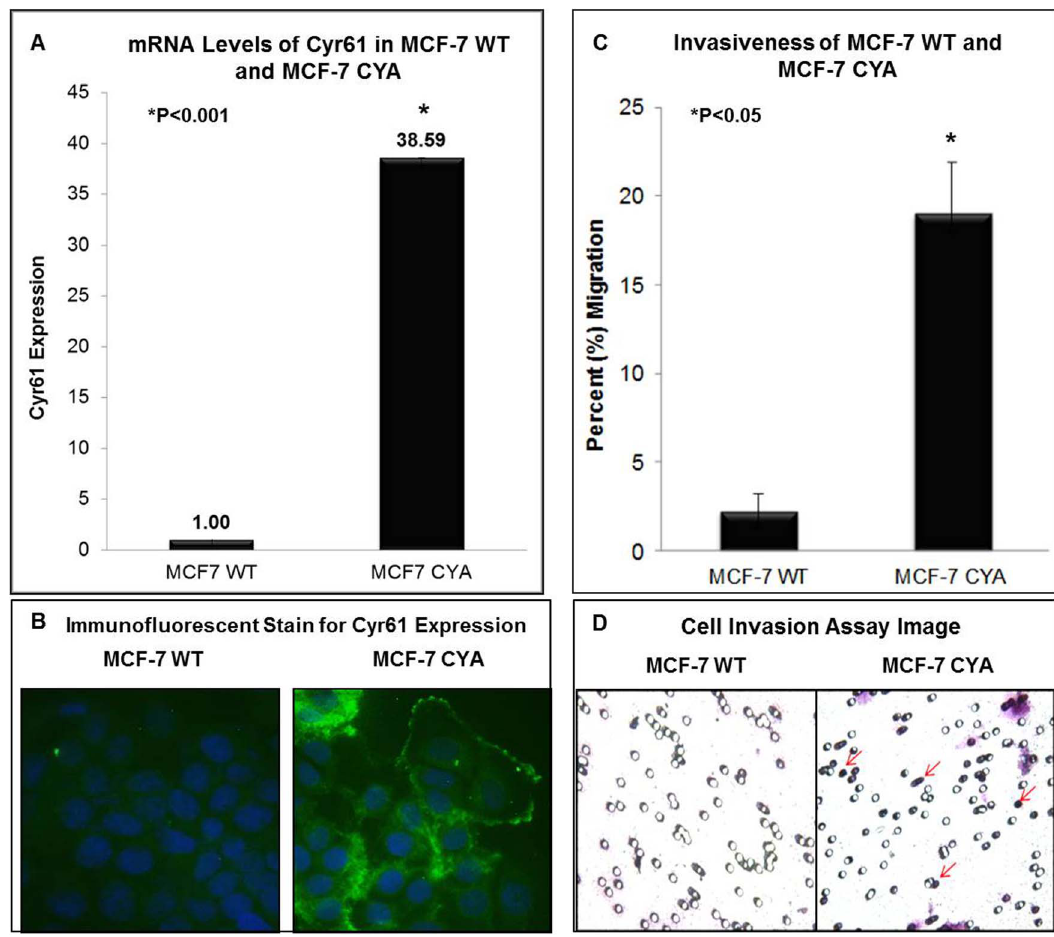
Figure 2. Confirmation of Cyr61 levels and Invasiveness in MCF-7 WT and MCF-7 CYA. ( A ) The mRNA expression of Cyr61 was assessed by RT-Q-PCR and ( B ) by immunofluorescent staining (FITC - green – Cyr61; DAPI – blue – nuclei). ( C ) Quantification of invasiveness from invasion chamber. ( D ) Red arrows demonstrate positive examples from invasion chamber. CYA cells are 9 times more invasive than the MCF-7 WT cells. All mRNA levels were adjusted for the housekeeping gene, 18S. P-values were calculated relative to MCF-7 and P , 0.05 is statistically significant.